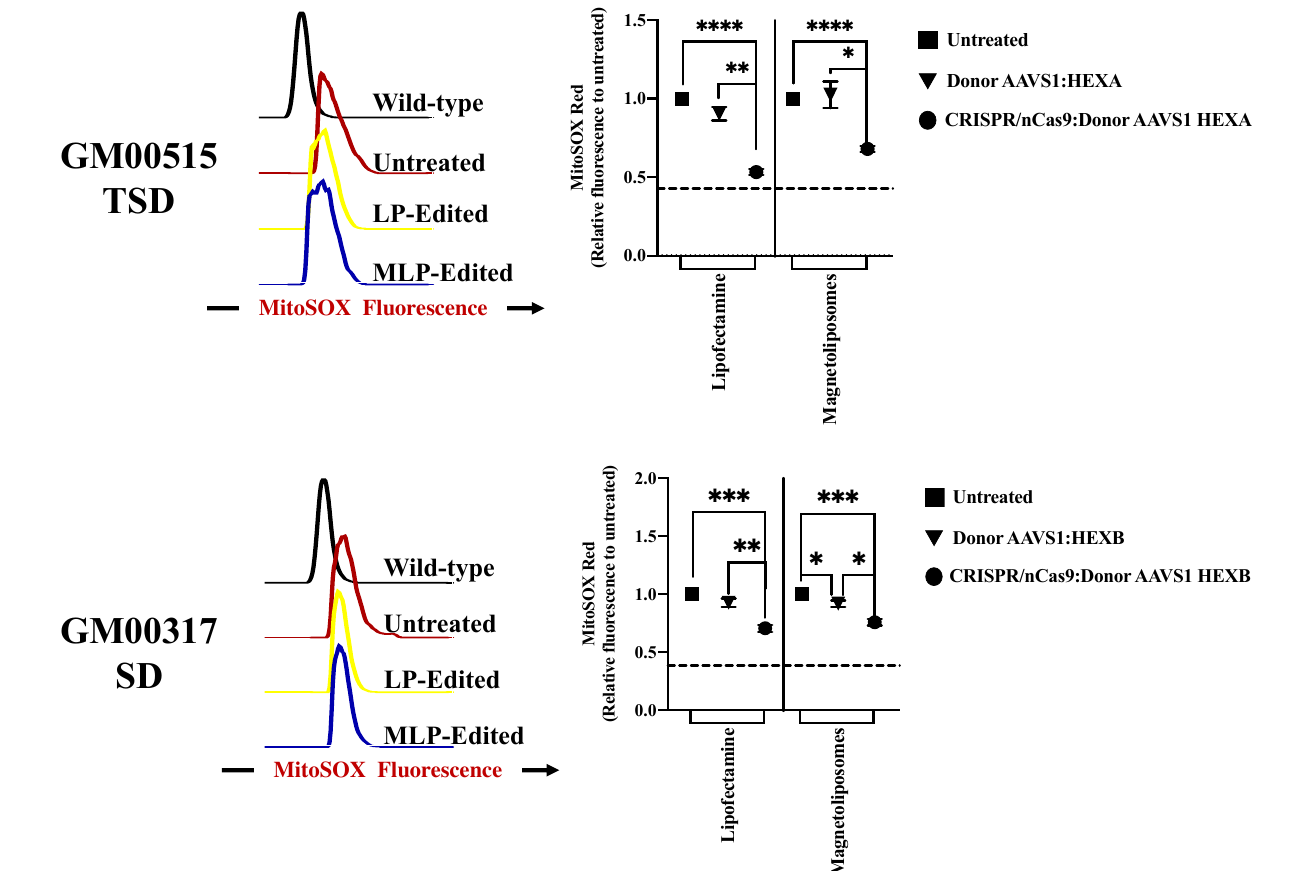
Figure 7. mtROS response on long-term edited GM2 fibroblasts. MitoSOX red fluorescence intensity for GM00515-TSD and GM00317-SD fibroblasts after one month of treatment. The left panels show representative histograms, while the right panels show the mean of three independent